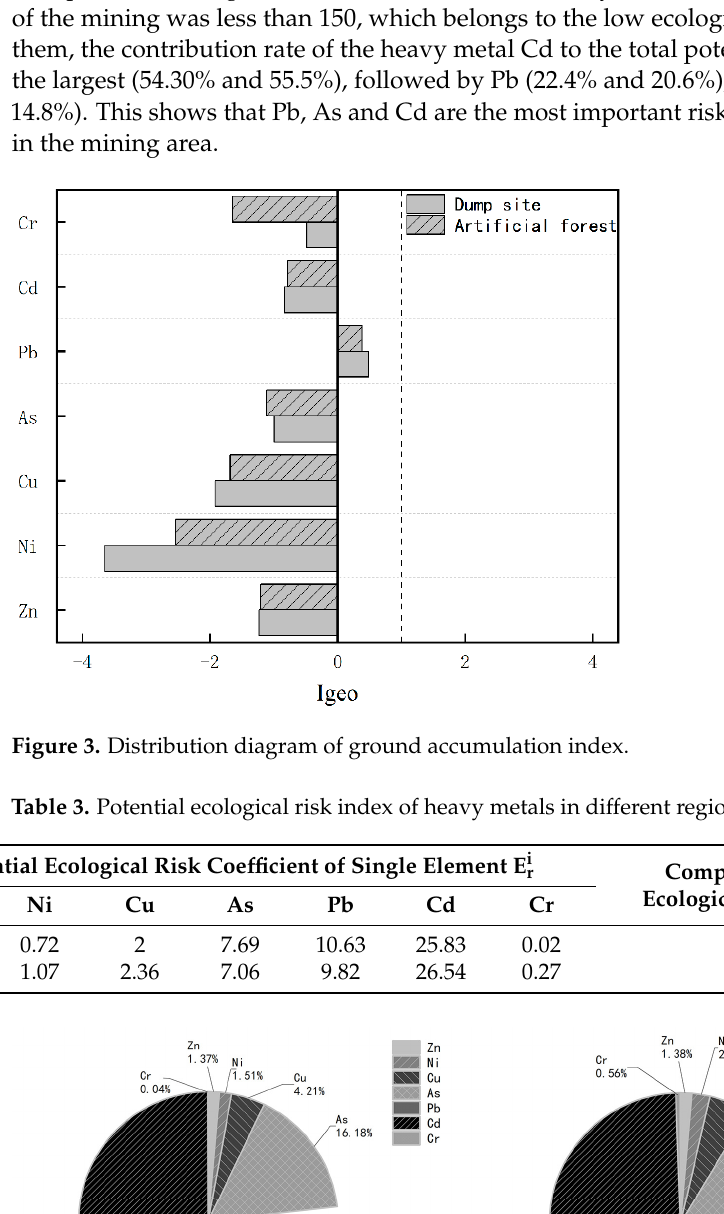
Figure 2. Boxplot of Heavy Metal Pollution Index.